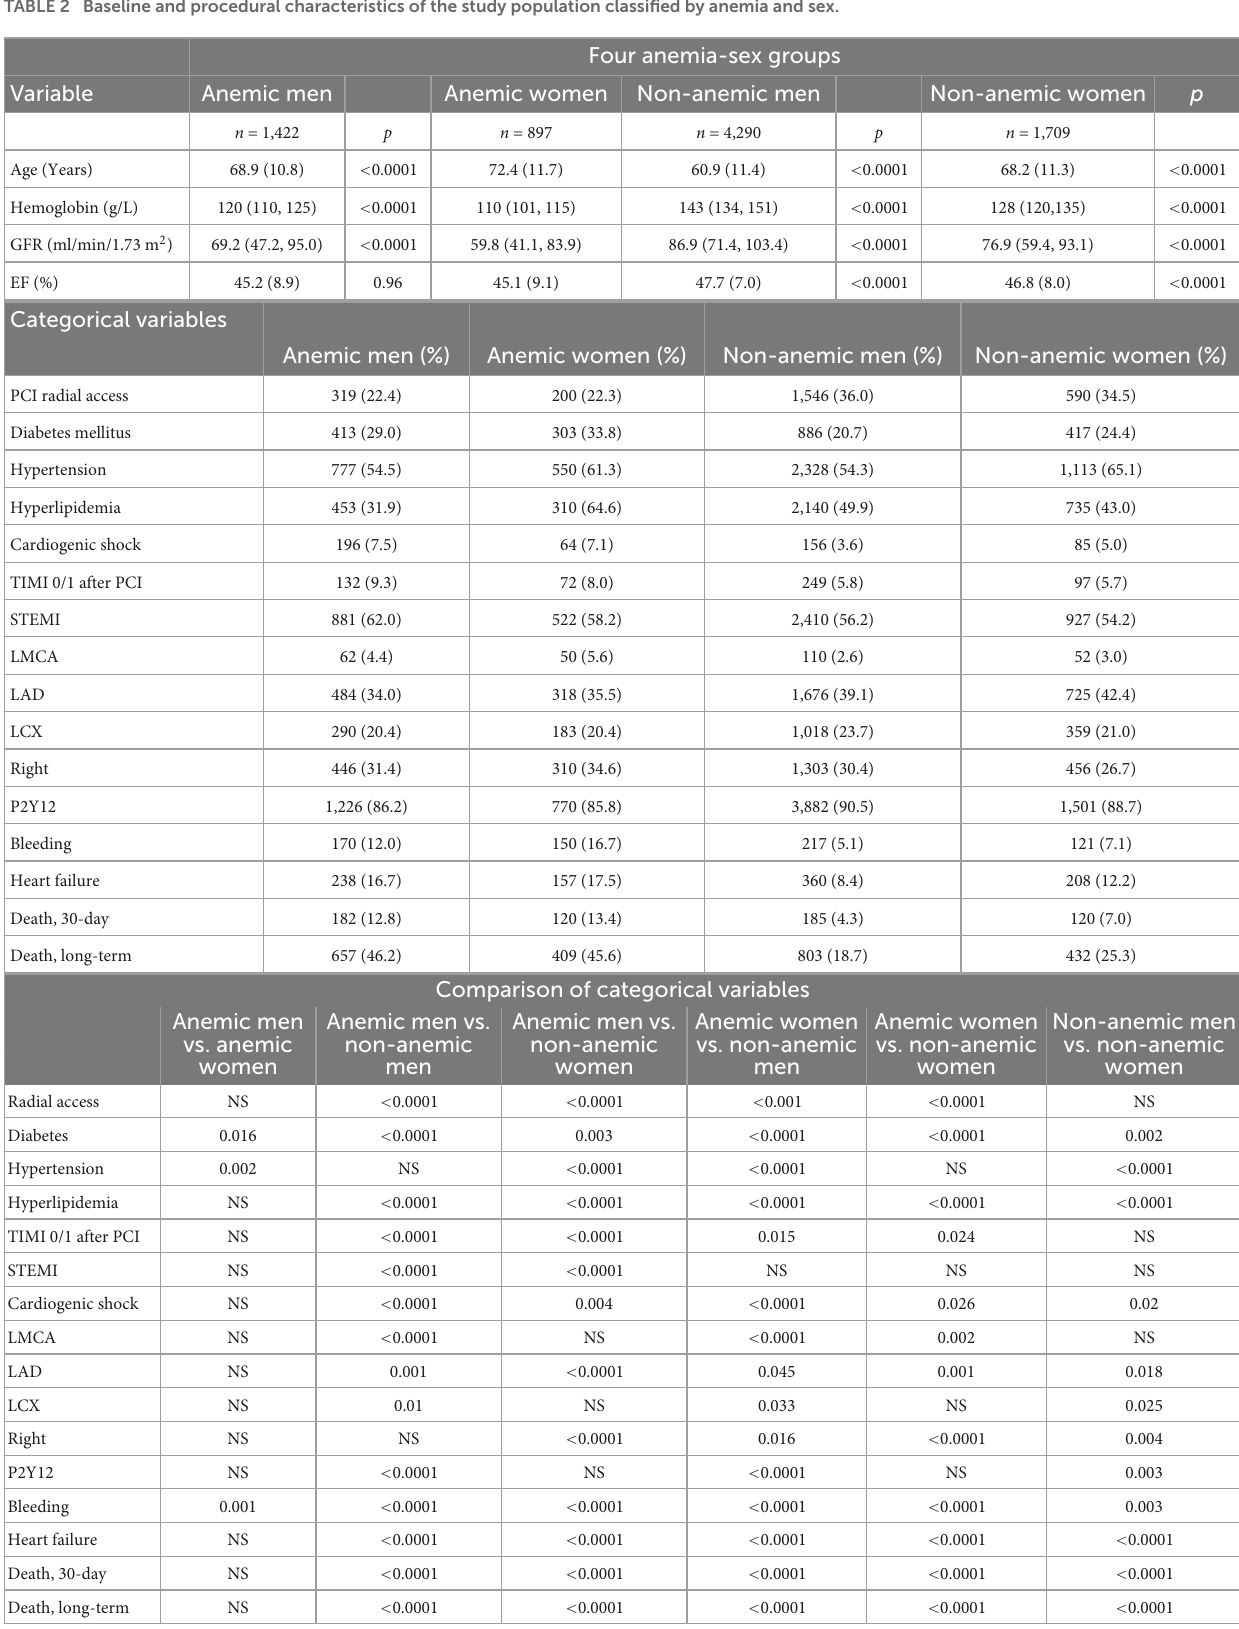
TABLE 2 Baseline and procedural characteristics of the study population classified by anemia and sex.